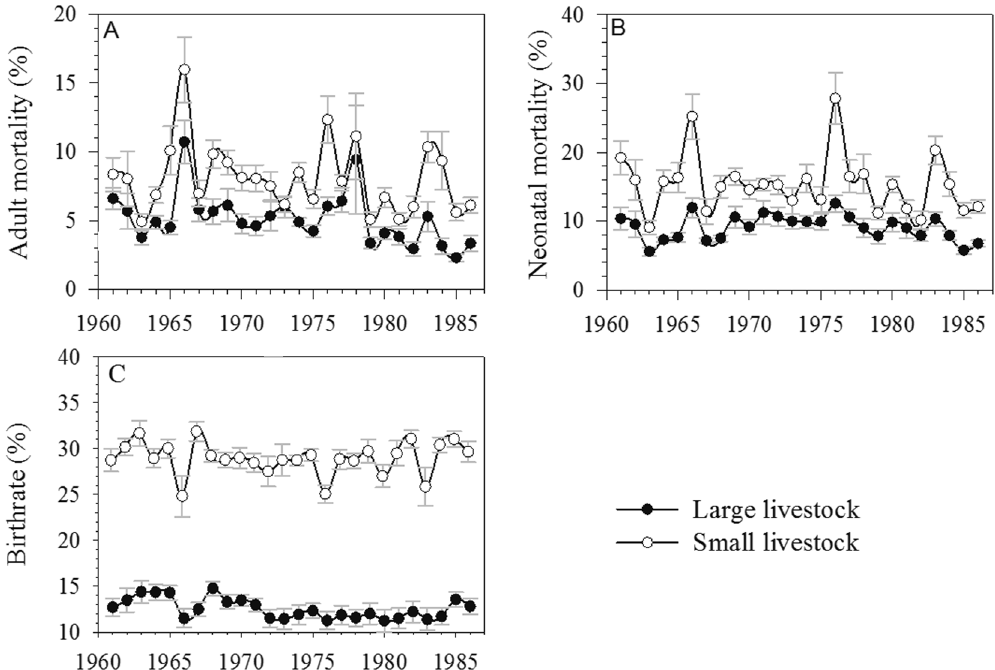
Figure 4. Overview of Livestock Population Dynamics between 1961 and 1986 in Inner Mongolia Note: Metrics were demonstrated on sub-district scale of Inner Mongolia: adult mortality ( A ), neonatal mortality ( B ), and birthrate ( C ). Black solid dot stands for large livestock, such as cattle, horse, and camel, while hollow dot stands for small livestock, such as sheep and goat. Solid dot represents mean value, and error bars represent standard errors from the 11